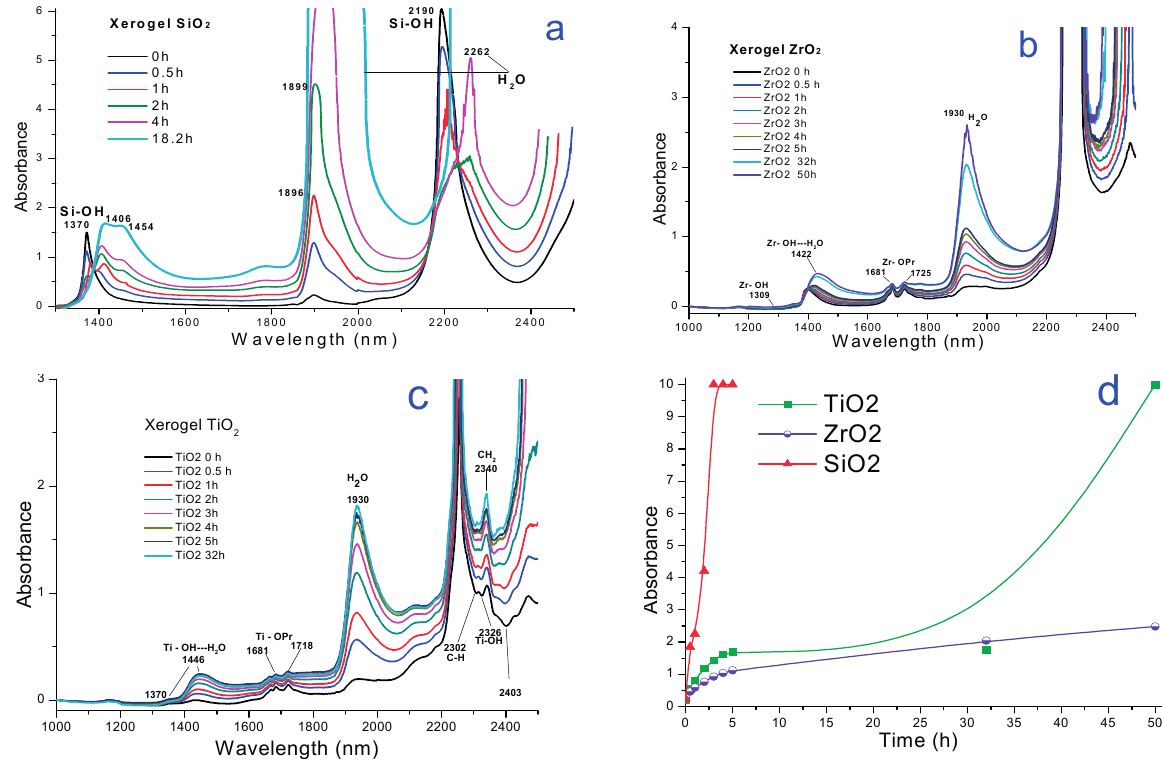
Figure 4. NIR monitoring of: ( a ) SiO 2 ; ( b ) ZrO 2 ; and ( c ) TiO 2 xerogels during water rehydration at 125 °C; ( d ) The intensity of the bands associated to physisorbed water is plotted as function of the rehydration